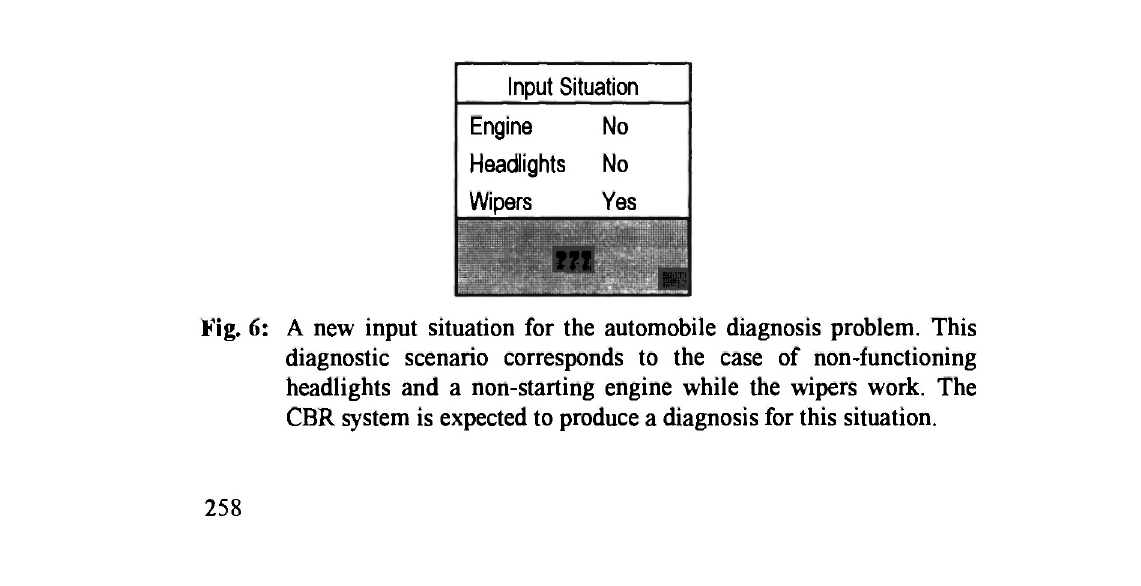
Table 1. The degree of match is a sum of the scores obtained by matching each of the indices in the input and the corresponding stored case.